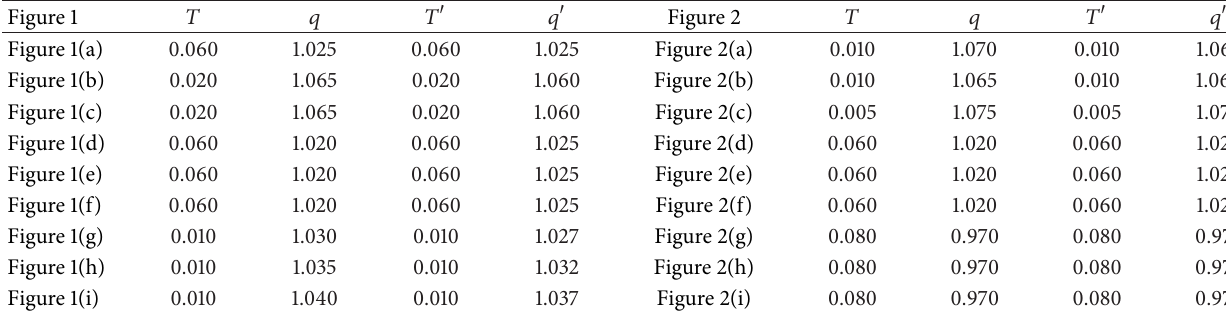
Table 1: Values of 𝑇 , 𝑞 , 𝑇 󸀠 , and 𝑞 󸀠 taken in Figures 1 and 2.